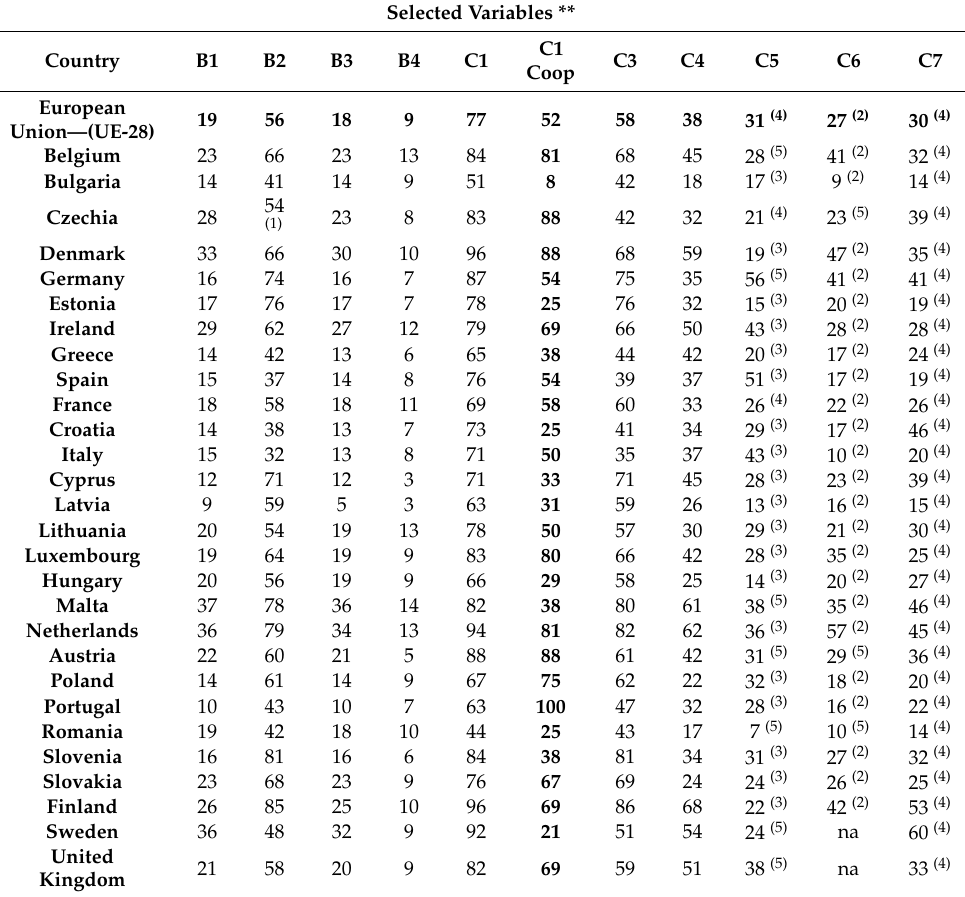
Table 4. Digitalization of the European business sector (EU28): website functionalities and ecommerce (2018). Source: own development based on Eurostat (several years) and of the data collected in the